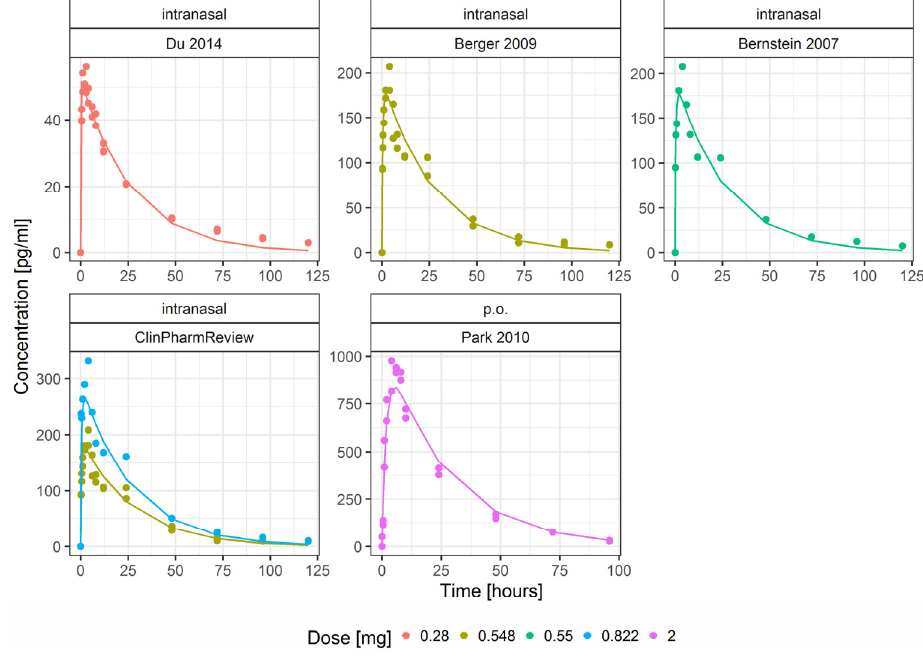
Figure A2. Azelastine plasma concentration-time profiles after intranasal or oral application of various amounts. Points represent observations from 5 different studies [6–10] and lines represent model predictions of the PK model A. Colors indicate dose amounts.